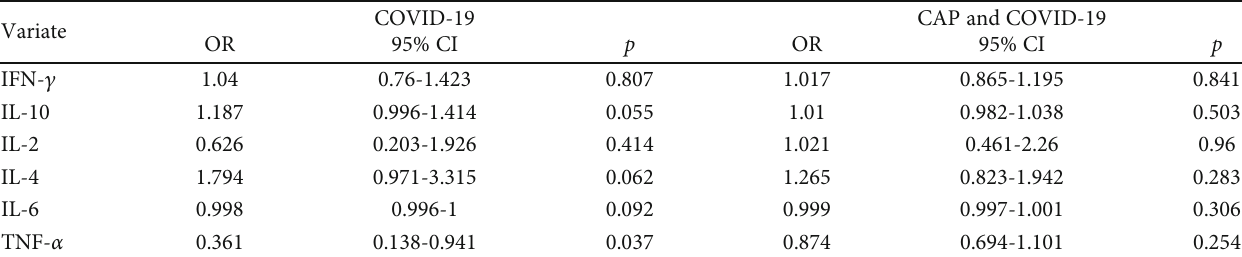
Table 5: Multivariate predictors of cytokines on disease